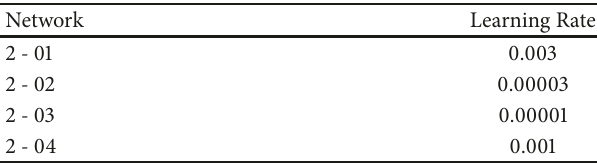
Table 3: Learning rates for new trainings using dataset from Network 2.